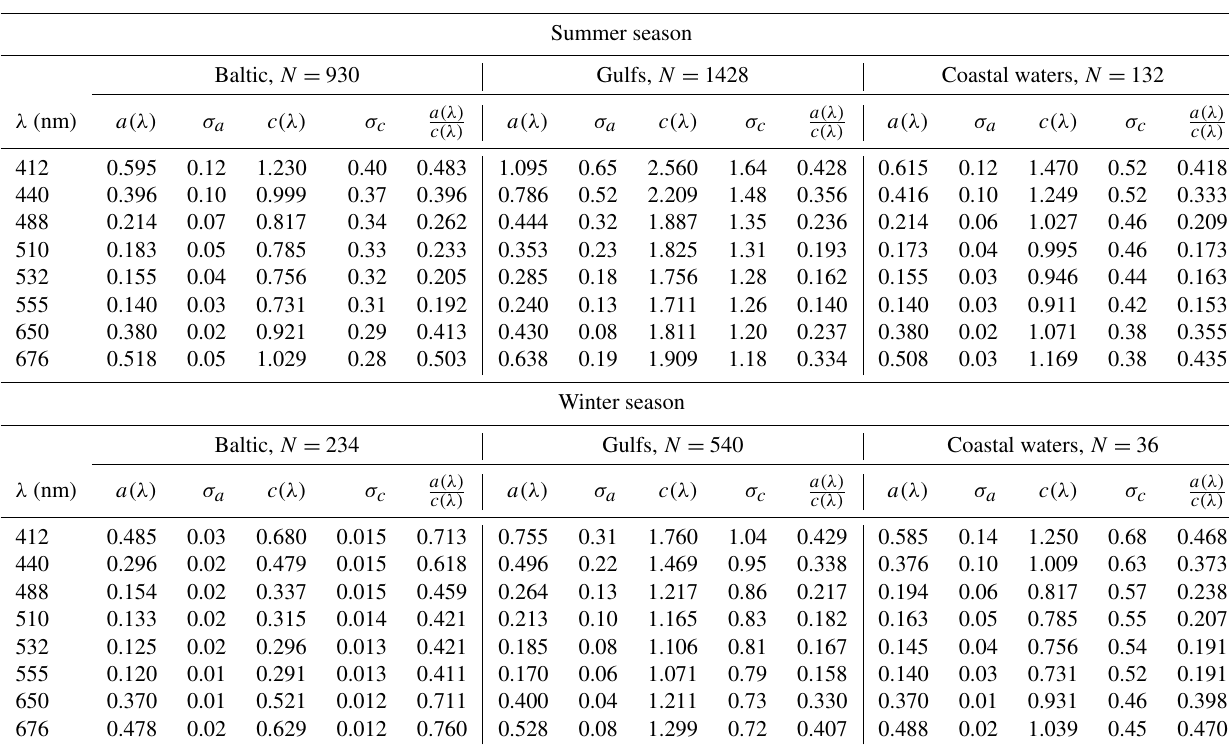
Figure 1. The area of the southern Baltic Sea, on which the positions of measurement stations are marked, divided into three areas: Pomera- nian Gulf and Gulf of Gda´nsk ( + ), coastal water ( (cid:49) ) and open Baltic water ( • ). Table 1. Average values of total absorption coefficients, total attenuation coefficients, their standard deviations and their ratios. All values measured by Sagan (2008) in southern Baltic in 1999 and 2003 to 2005 are averaged for depths 0 to 5m and then averaged for N measuring